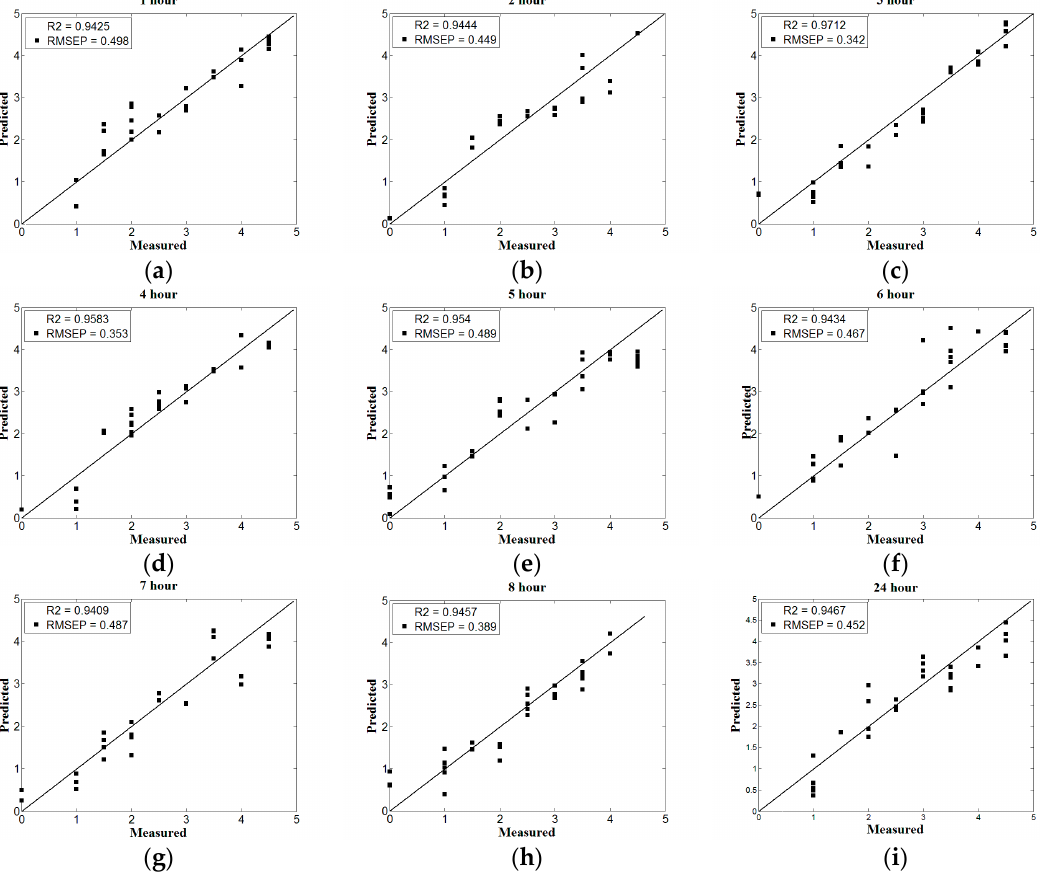
Figure 2. The partial least squares (PLS) model performance under different drying time. ( a – i ) represent the drying time from 1 h to 8 h and 24 h respectively.